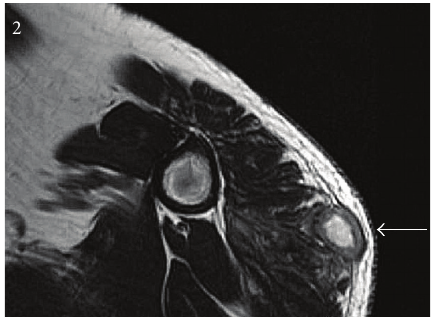
Figure 2: Magnetic resonance imaging (MRI) shows a complex, infiltrative maximally 9cm mass in the left deltoid, extending from subcutaneous to deep tissues to abut the humerus, with underlying normal marrow. The lesion is composed of interlinked foci of abnor- mal tissue with intense central enhancement, suggesting